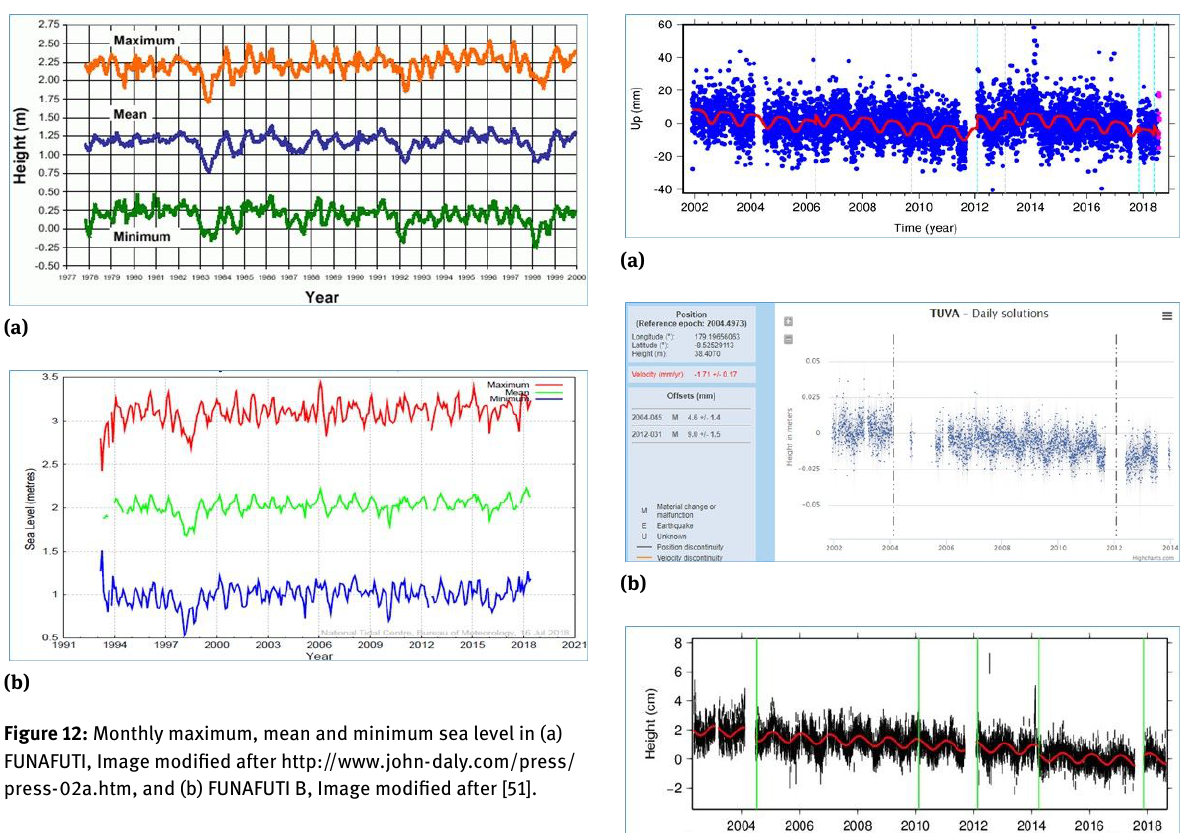
Port Pirie sea levels were previously analyzed by [67].